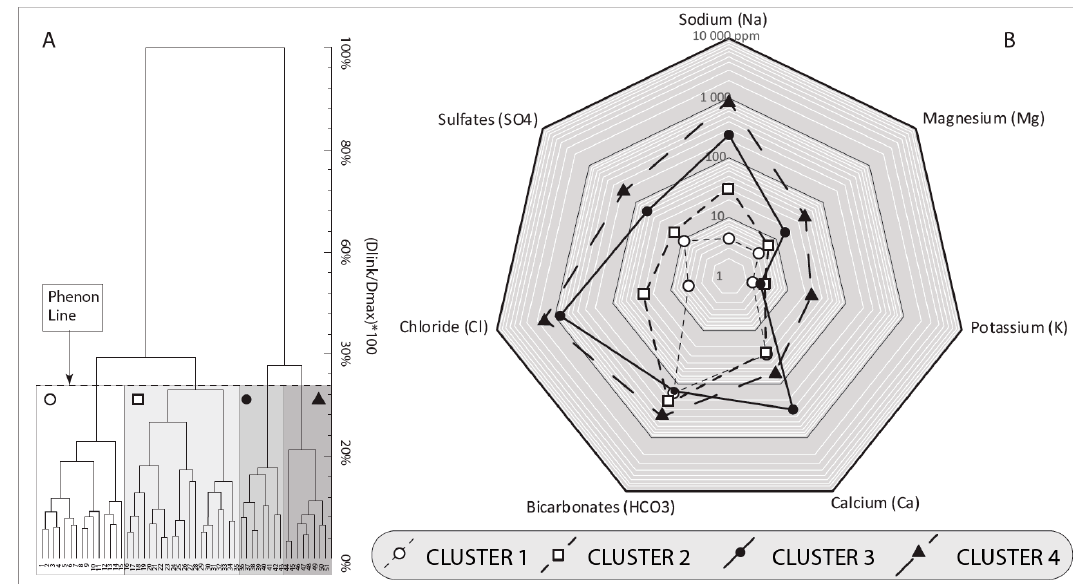
Figure 7. ( A ) Dendrogram of the hierarchical Cluster analysis: when distance linkage (Dlink) is <30% of Dmax (i.e., position of the phenon line), the subset is divided into 4 Clusters (C1 to C4). ( B ) Log-scale spider diagram of major cation and anion concentrations for the 4 Clusters. Clusters 1 and 2 correspond to more dilute groundwater where bicarbonate ion dominates, Cluster 4 is enriched in major elements when compared to Clusters 1, 2, and 3, and calcium dominates Cluster 3.